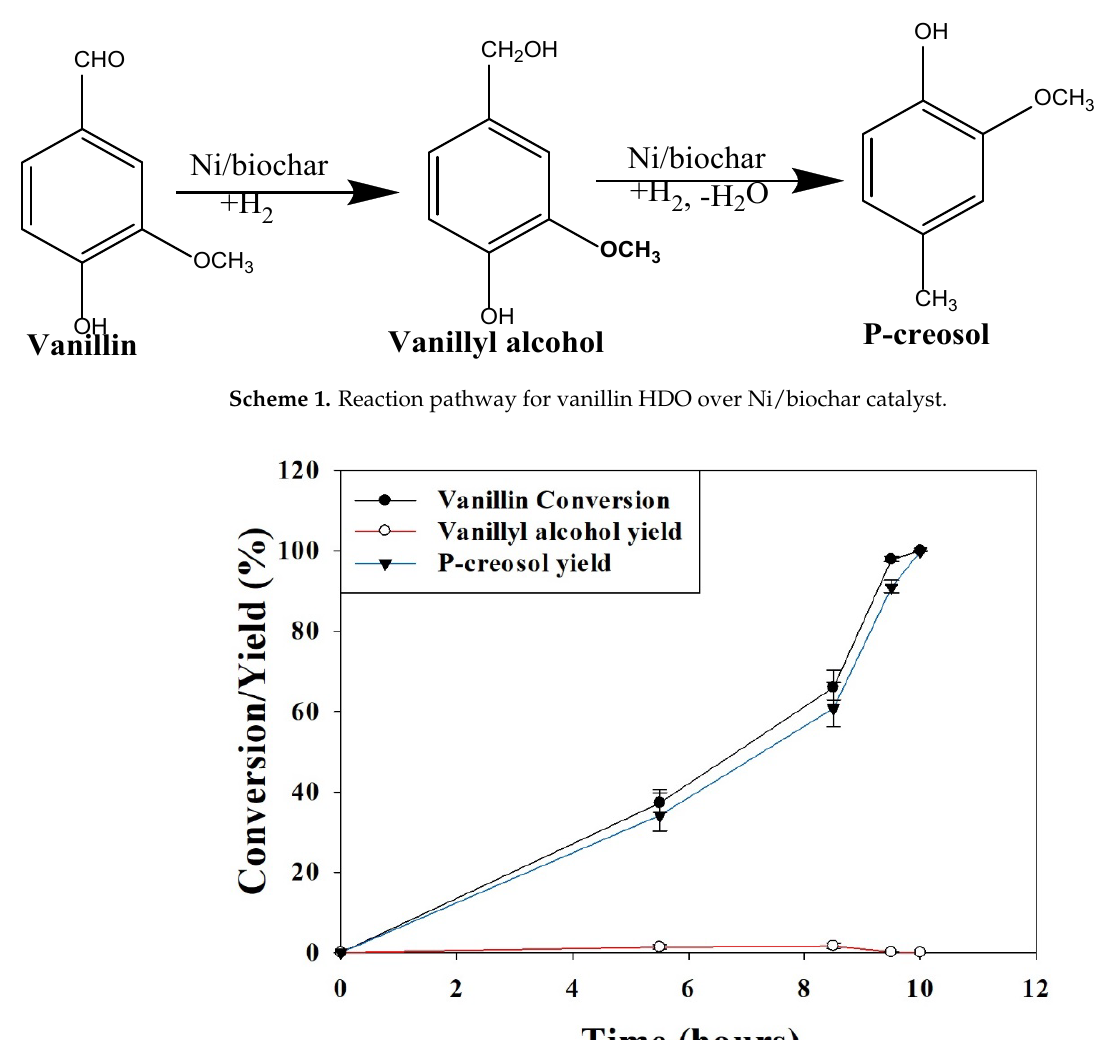
Figure 9. Conversion and product yield from vanillin HDO over Ni/biochar catalyst (reaction con- ditions: initial substrate concentration 0.33 M; temperature 150 °C; H 2 pressure 50 bar; catalyst 0.8 g; reaction time 10 h).